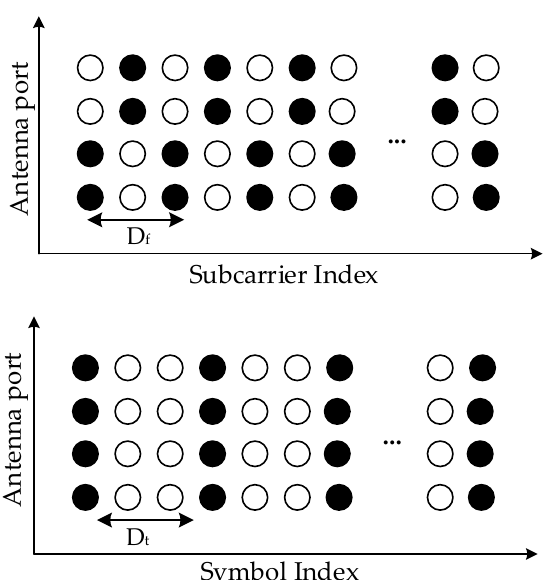
Figure 4. The pilot structure used in the considered MIMO-OFDM